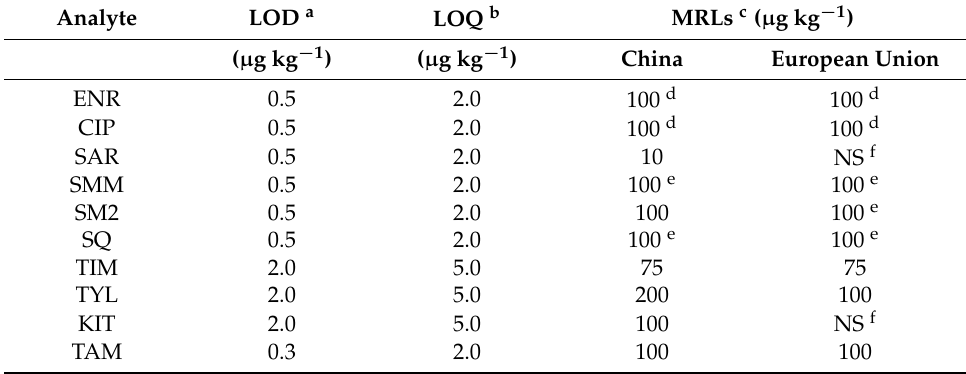
Table 3. LOD and LOQ for the method and the MRL values of 10 drugs in chicken